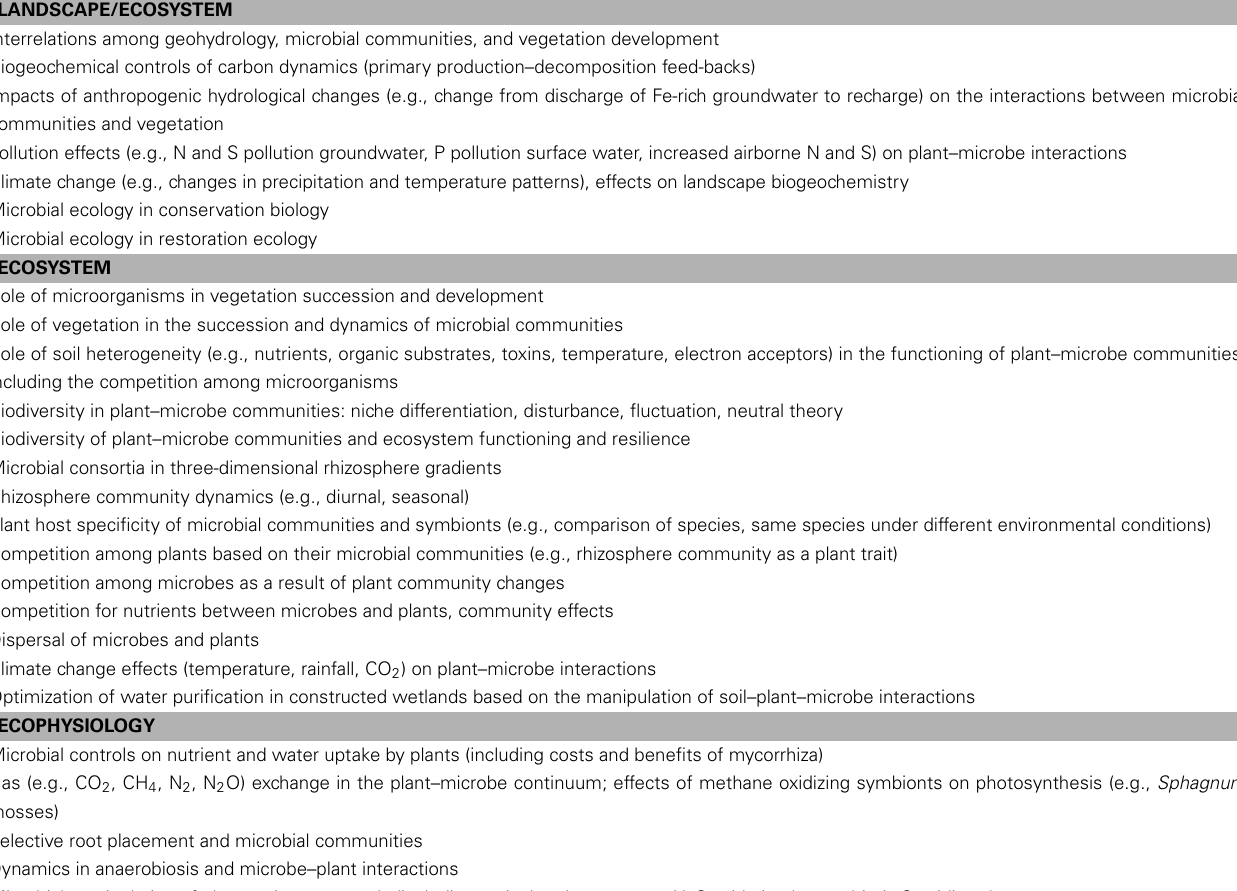
Table 1 | Examples of fundamental and applied ecological challenges regarding plant–microbe communities in wetlands (and other ecosystem